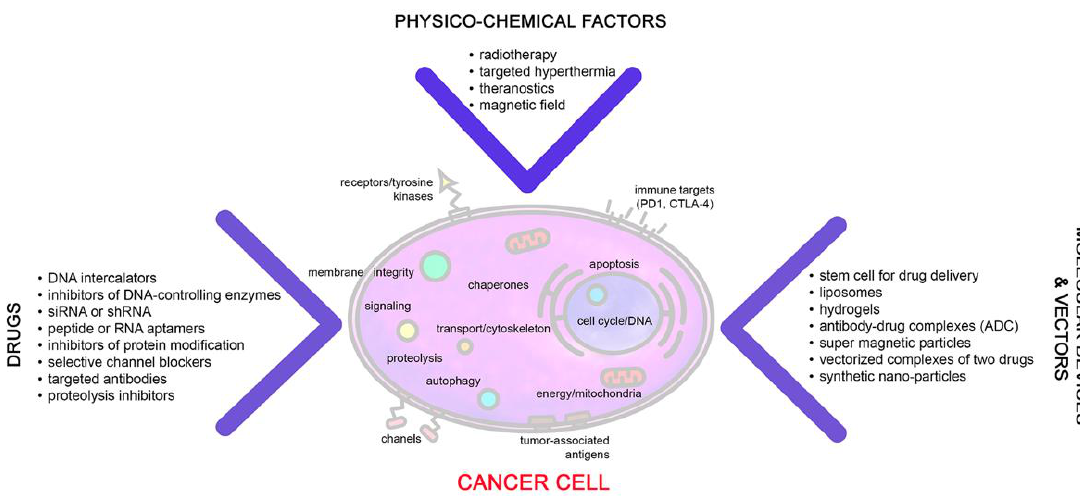
Figure 1. Currently used drugs, physico-chemical factors, molecular devices and vectors, which are presently tested in combinatorial treatment approaches of cancer. 59